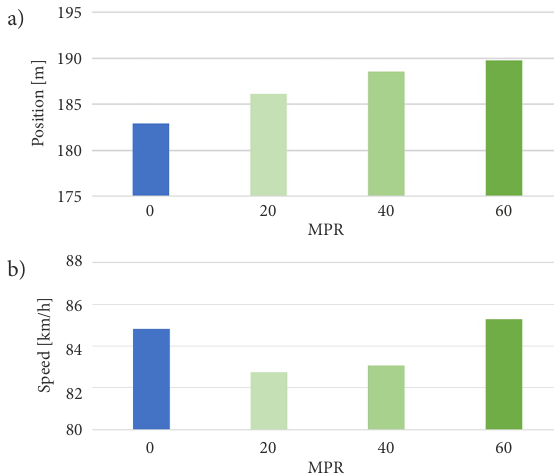
Figure 12. Merging position on the acceleration lane [m] (a) and average speed on the acceleration lane [km/h] (b) – headway adaptation